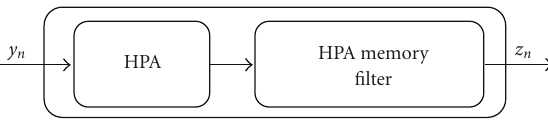
Figure 6: Model of the HPA with